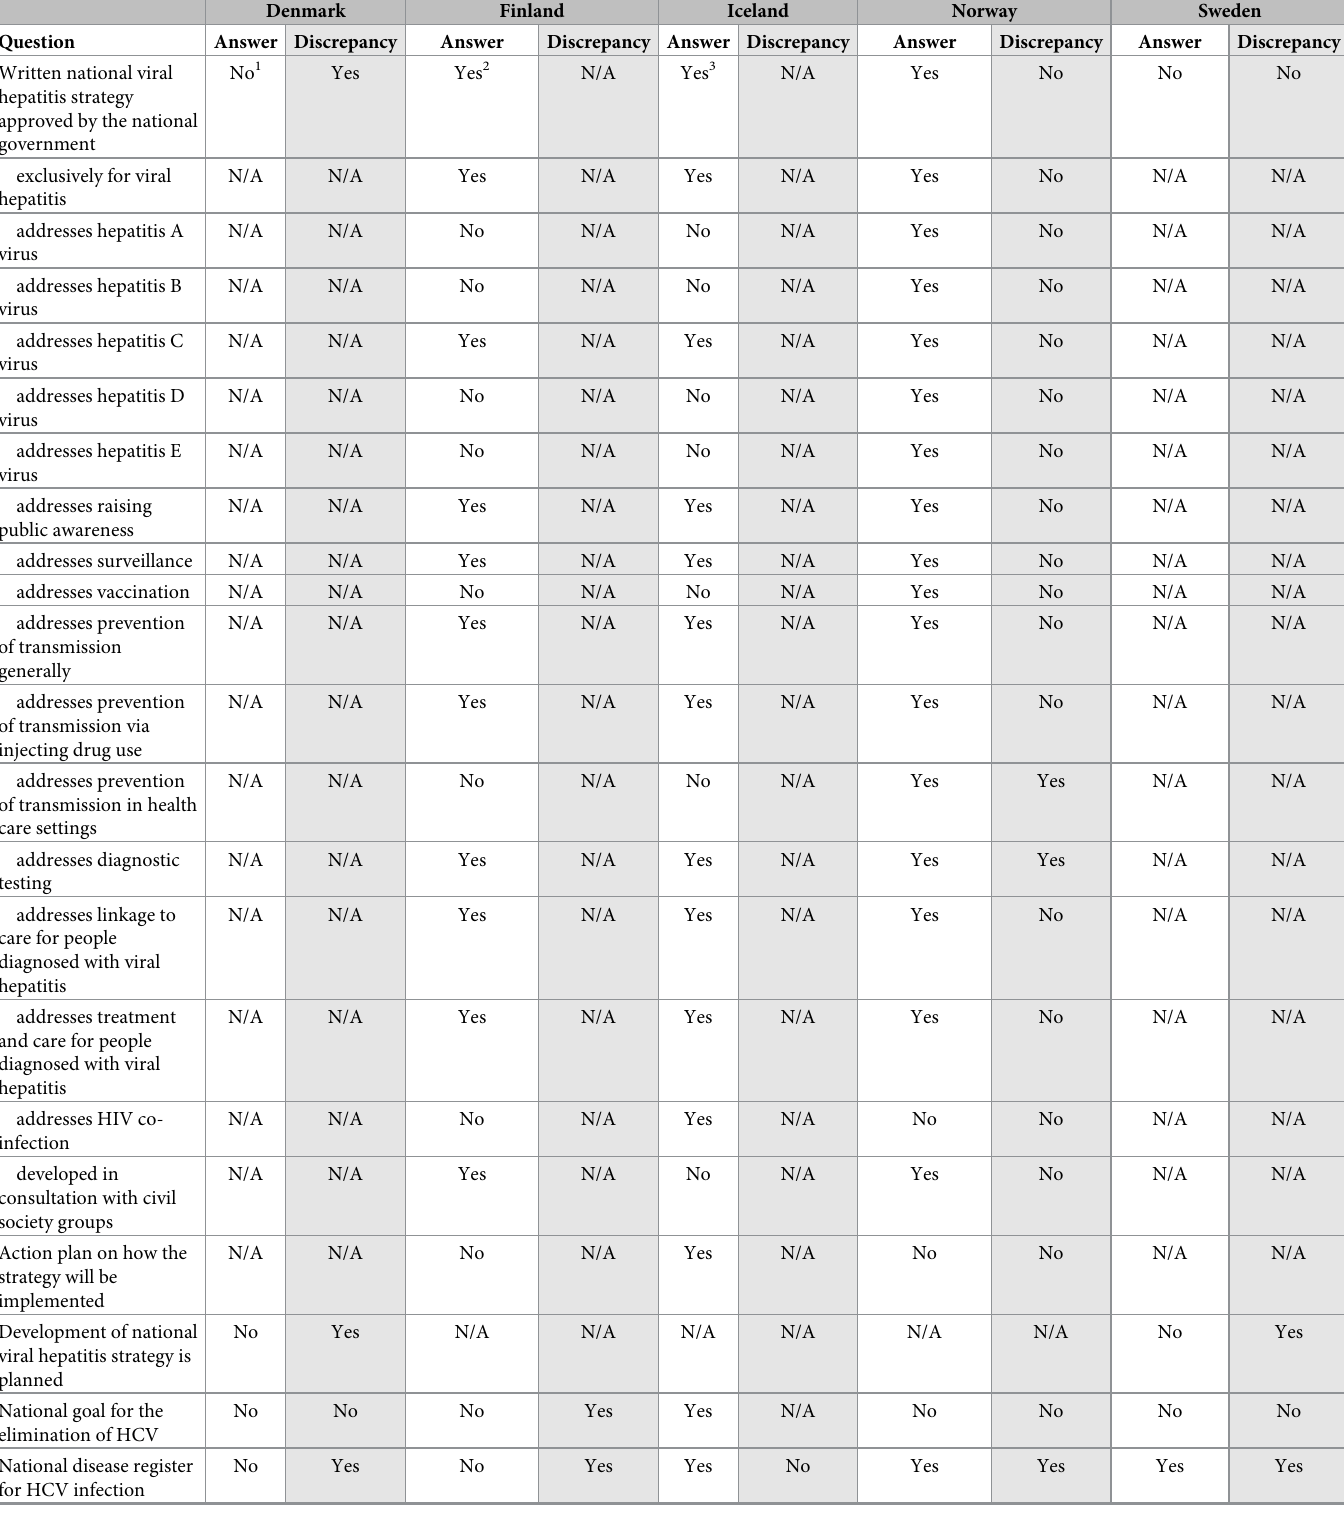
Table 1. NATIONAL